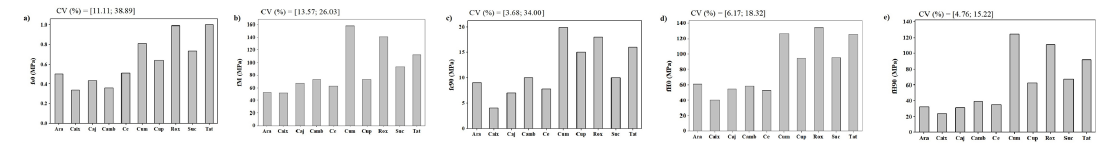
, f , f , f and f for wood species. (a) The variation of the mean values of the strength to cracking (f Figure 3. Mean values of f s0 M c90 H0 H90 (b) longitudinal modulus of rupture in static bending (f ), (c) strength in compression perpendicular to the fiber (f M parallel fiber (f ) , and (e) hardness of normal fiber (f ) as a function for wood species (Ara – Cedroarana; Cax – Caixeta; Caj – Cajueiro; H0 H90 Camb – Cambará; Ce – Cedro; Cum – Cumaru; Cup – Cupiúba; Rox – Roxinho; Suc – Sucupira; Tat – Tatajuba), respectively. Inserted in these Figure 3a-e upper side the lower and higher values of the coefficient of variation (CV)